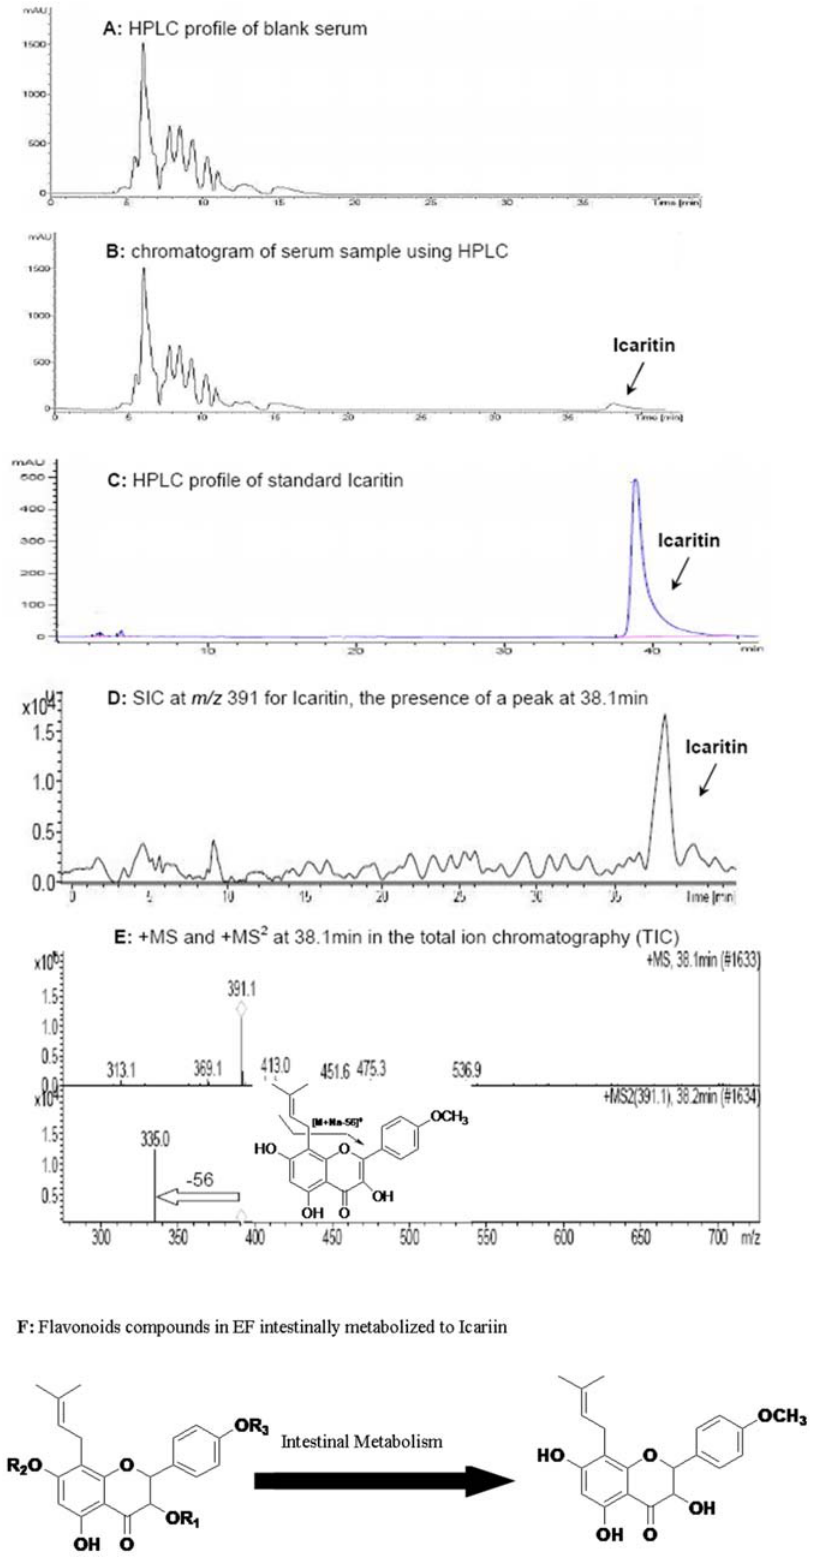
Figure 4. A total ion chromatogram in full scan mode generated by HPLC/UV/MS/MS. (A) , (B) Compared with the blank sera, a peak shown in 38.1 min in the sera from L-EF, M-EF and H-EF group. (C) HPLC profile of standard Icaritin. (D) 391 ( m/z [M + Na] + ) for Icaritin selected for the subsequent selected ion chromatography (SIC), with a peak at 38.1 min. (E) The + MS showed the mass weight by 391 ion ( m/z [M + Na] + ) and the absence of 56 exhibited the existence of prenyl in the + MS 2 chromatography. (F) Epimedium -derived flavonoids with common stem nuclei intestinally metabolized to Icaritin.